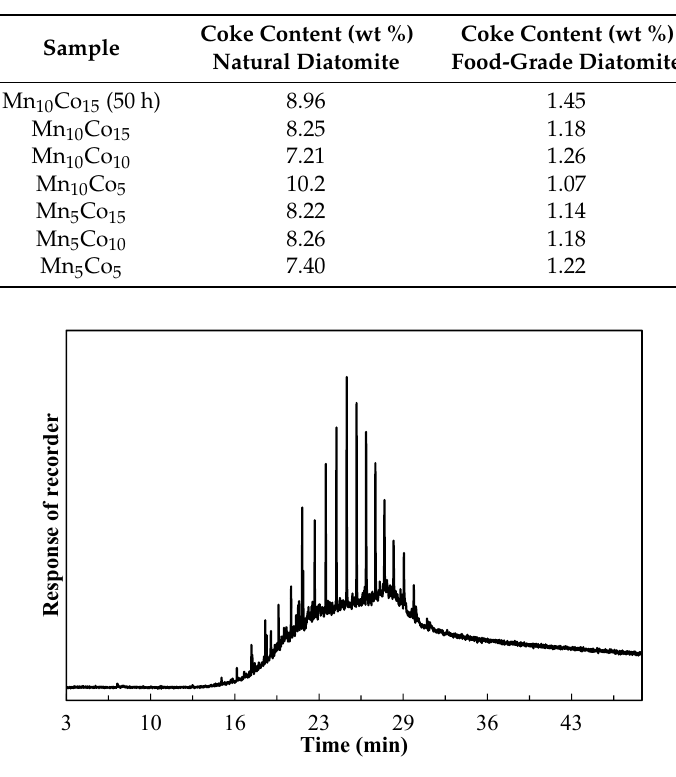
Figure 9. Chromatograms of the carbonaceous compounds retained on Mn 5 Co 15 /F. Table 6. Molecular composition of the soluble fraction of the coke.